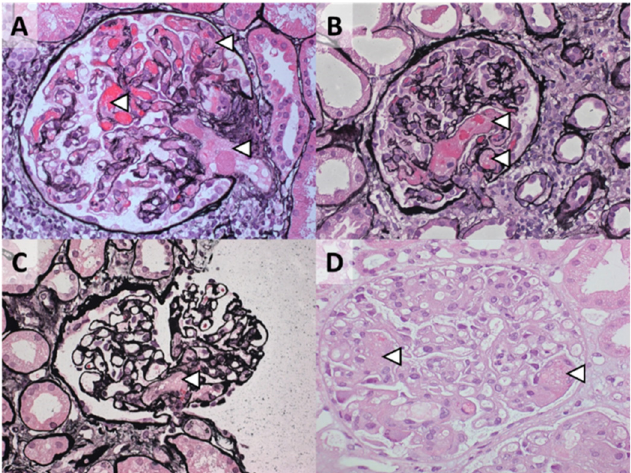
Figure 4. Morphologic features of TMA on kidney biopsy cannot define etiology. Representative cases of TMA presenting with coexisting hypertensive emergency: ( A ) 28-year-old woman with a gain-of-function C3 protein (p.R161W); ( B ) 47-year-old man with no rare variants in complement genes identified, after surgery; ( C ) 37-year-old woman with no rare variants in complement genes identified, and coexisting pregnancy; ( D ) 28-year-old woman with no rare variants in complement genes identified. The arrowheads indicate glomerular thrombosis, often accompanied by mesangiolysis. Jones methenamine silver ( A – C ) and hematoxylin and eosin ( D ) staining; original magnification, ×400.